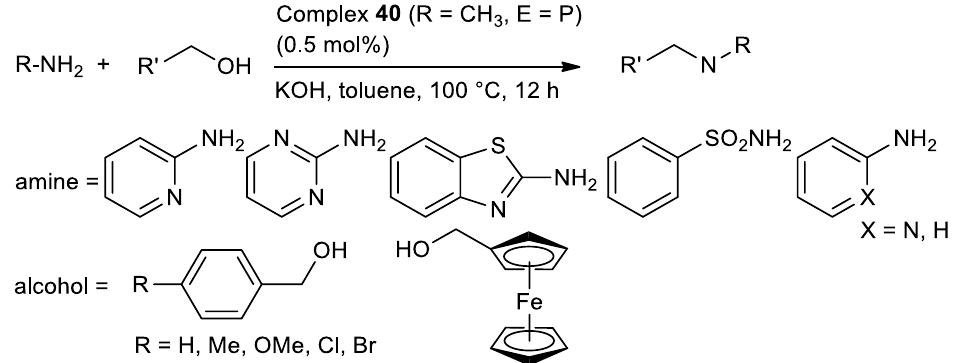
Table 4. Carbon – heteroatom coupling reactions catalysed by thiosemicarbazone complexes: representative conditions and